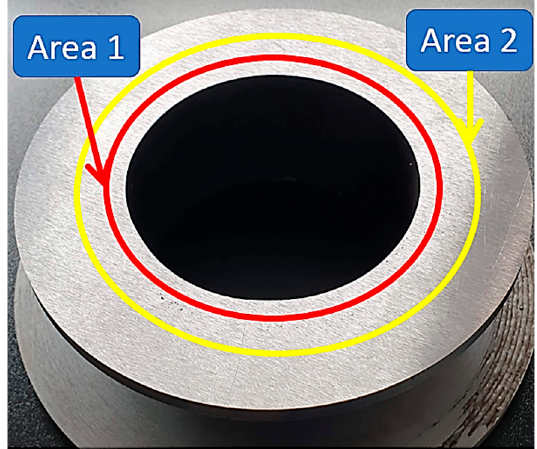
Figure 15. Highlighting the areas where hardness has been checked. Red circle: first deposition layer, Yellow circle: in the center of the successive deposited layers.